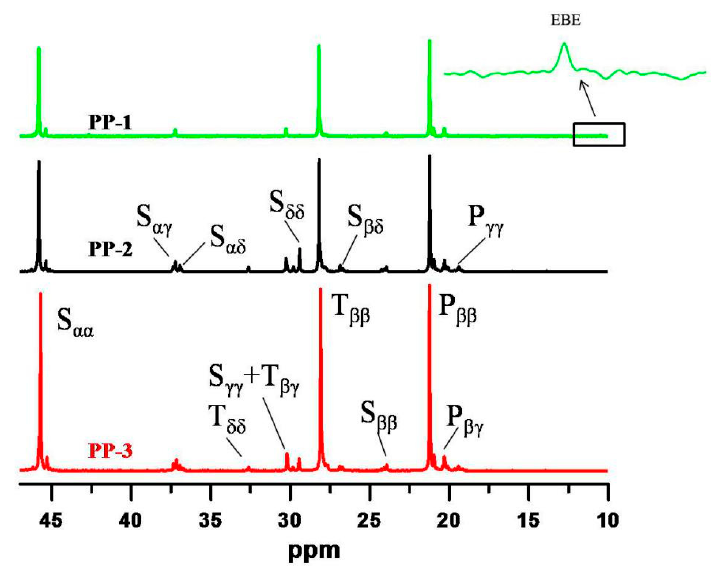
Figure 4. 13 C NMR spectra of the obtained samples PP-1, PP-2, and PP-3 measured at 120 °C using o-C 6 H 4 Cl 2 / o-C 6 D 4 Cl 2 (50% v / v ) as the solvent.